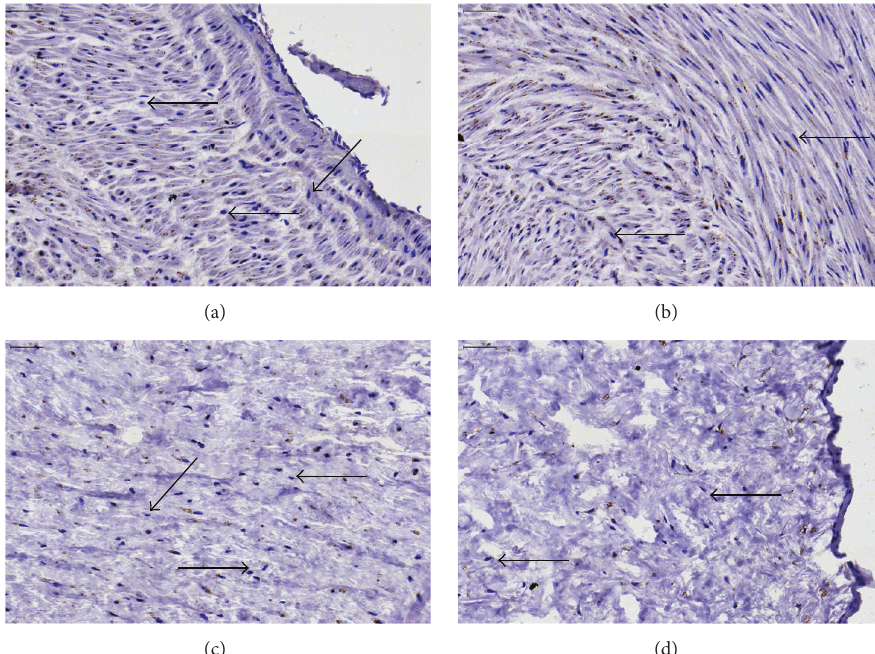
Figure 9: Staining of umbilical cord tissue for ALDH1A1 expression (brown). Images are shown for umbilical cord areas: (a) vein, (b) arteries, (c) Wharton’s jelly, and (d) cord edge and amniotic epithelium. Slides were counterstained using Mayer’s hematoxylin (dark blue = cell nuclei). Scale bars = 50 𝜇 m. Unstained cells (black arrows) are found in all anatomical compartments of the cord. Representative images of 3 different experimentsareshown.ImagesofcontrolstainingwithoutprimaryantibodyareavailableintheelectronicSupplementaryMaterial,Figure S1. Scale bars = 50 𝜇 m (top left